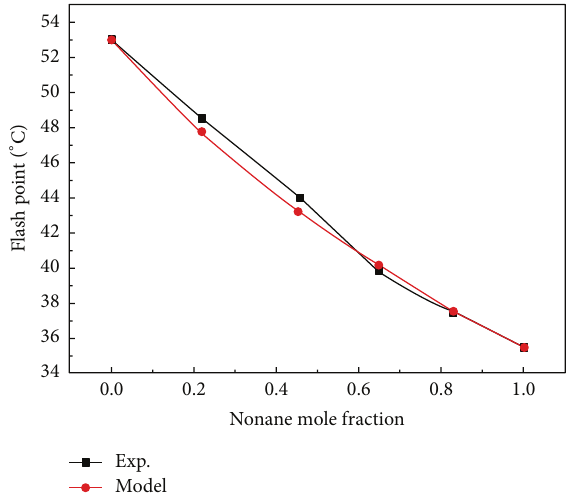
Figure 2: Flash point of nonane + decane with different mole